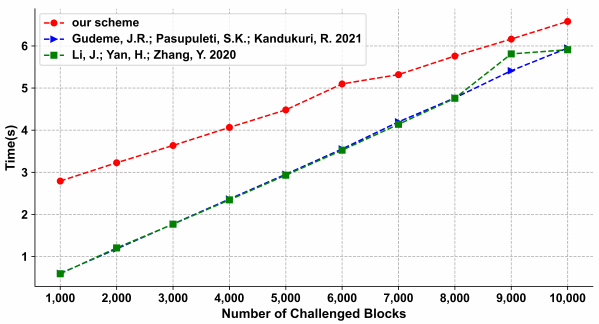
Figure 5. Computation cost of ProofGen [8,15].